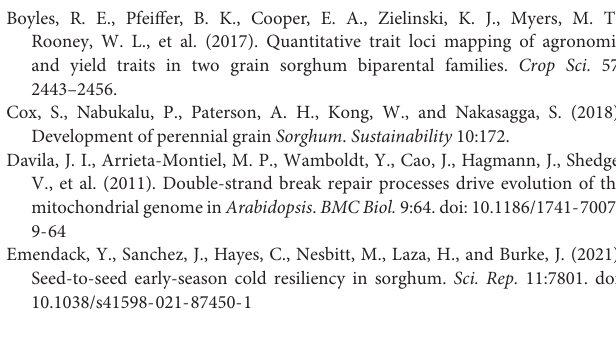
Supplementary Figure 8 | Identified overlap between DEGs from the low-N sensitive genotype (CK60) vs. tolerant genotype (High RIL) comparison under low-N condition and the DEG dataset from Tx430 epi-F3 line comparison generated in the study ( Supplementary Figure 6 ). (A) Venn diagram of the 130 genes present in both DEG datasets, accounting for 20% of CK60 vs. High RIL DEGs and 13.7% of Tx430 high-epiF3 vs. low-epiF3 DEGs. (B) Enriched pathways identified for DEG dataset from the genetic (CK60 vs. High RIL) comparison (Gelli et al., 2014) and the Tx430 epi-line comparison. The